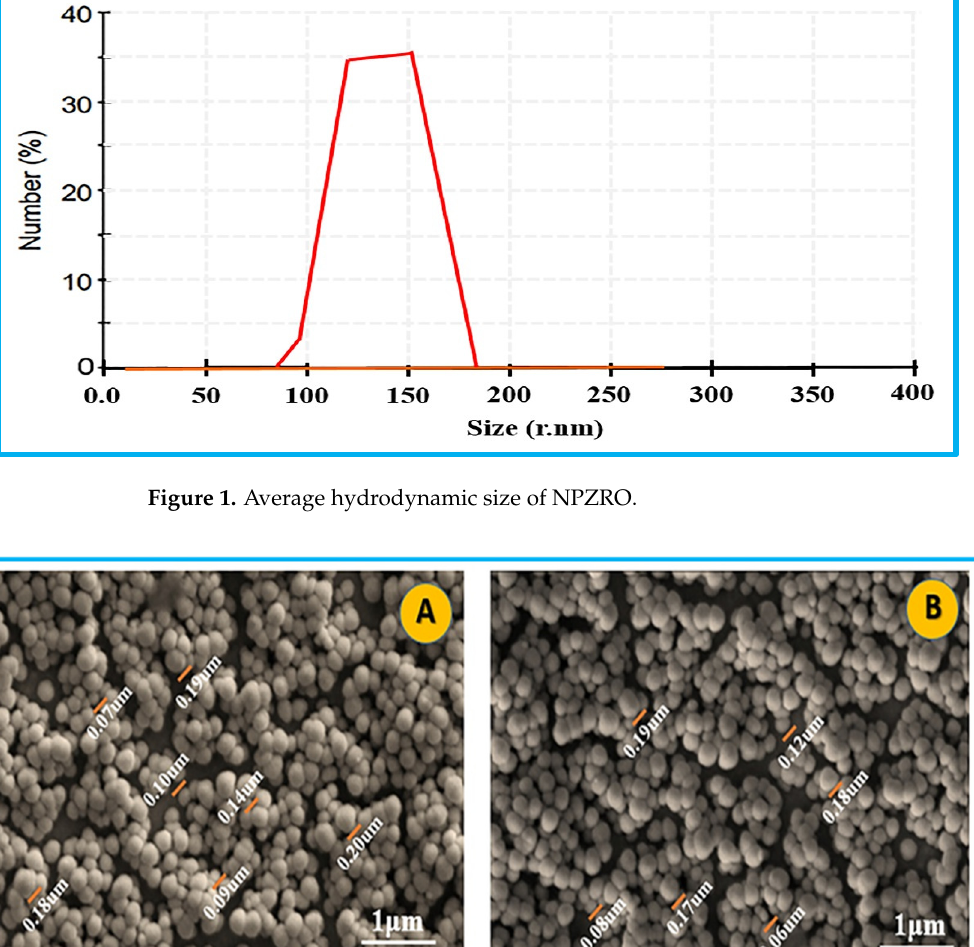
Figure 2. SEM images for NPZLA ( A , B ).